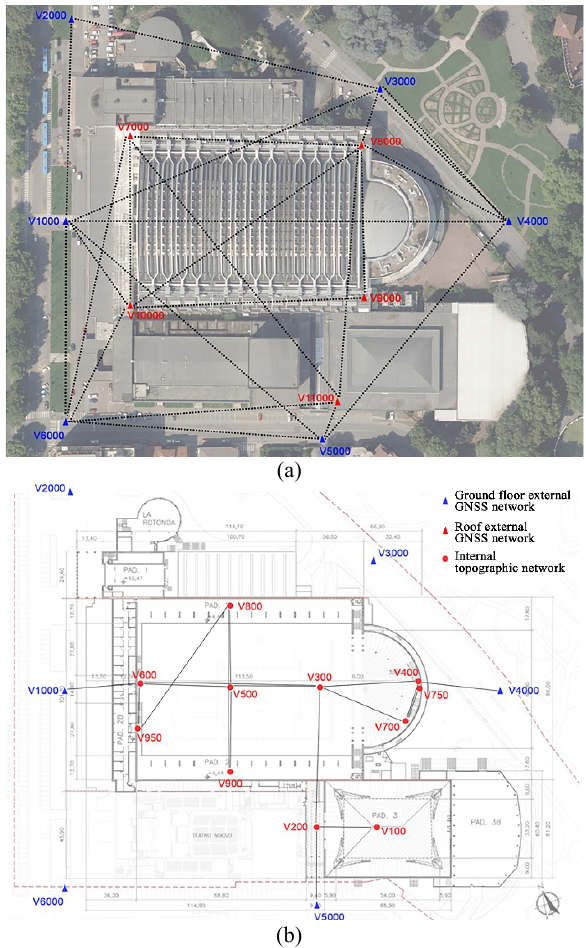
Figure 2. The topographic network and vertices distribution The establishment of a common reference system by